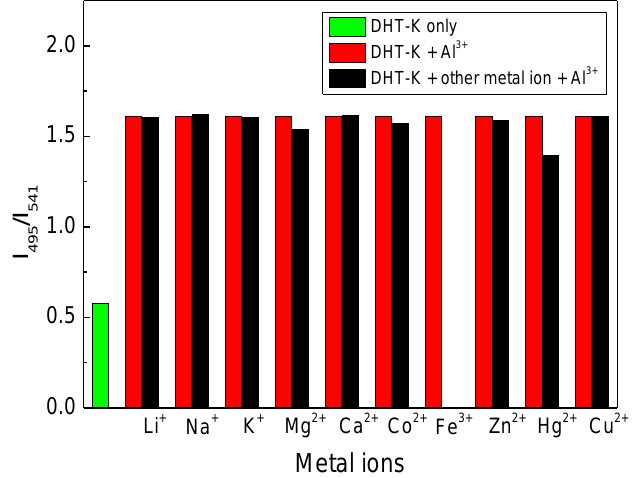
Figure 4. Changes in the fluorescence of DHT-K in the presence of Al ions (20 equiv) and other cations (20 equiv).